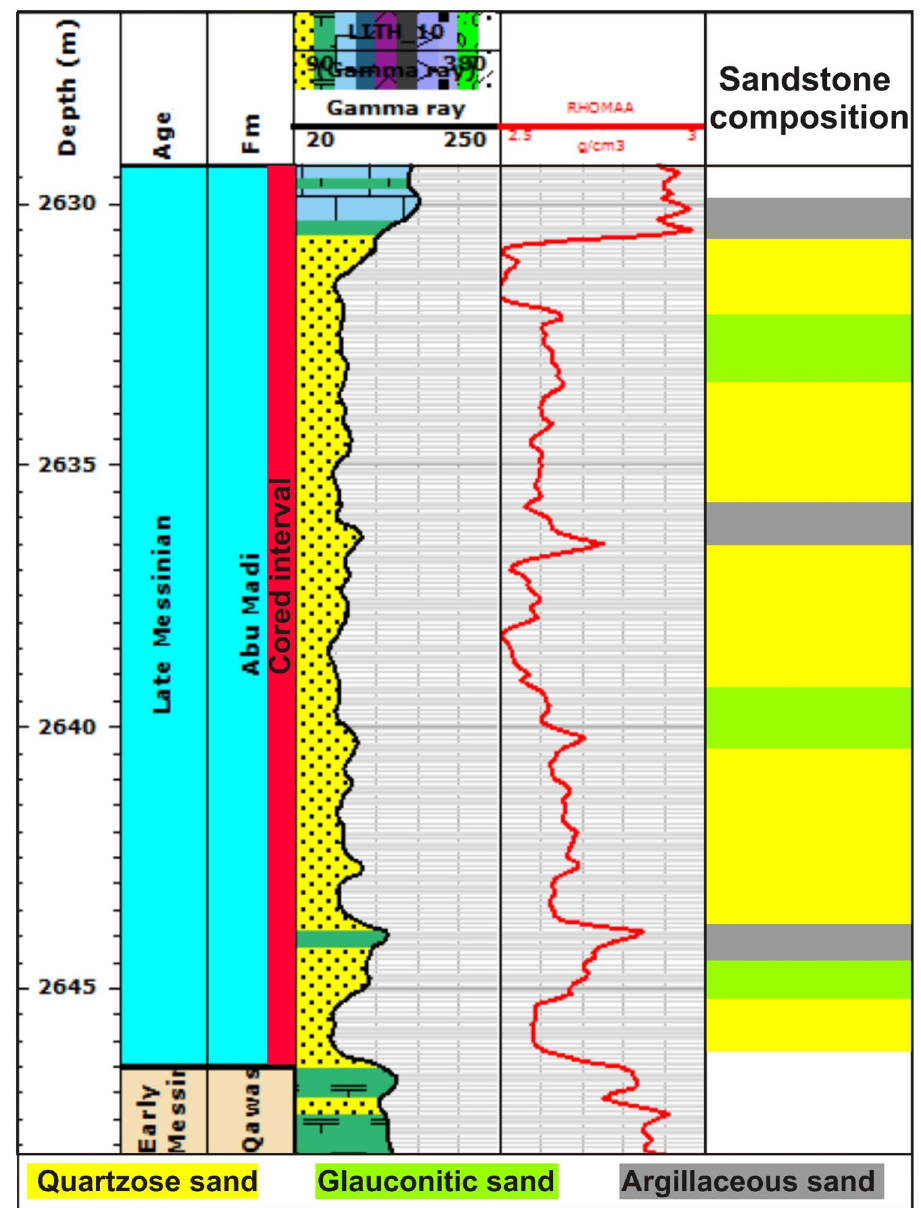
Fig. 8 Composition of the cored interval of Abu Madi fluvial sandstones and their corre- sponding wireline log